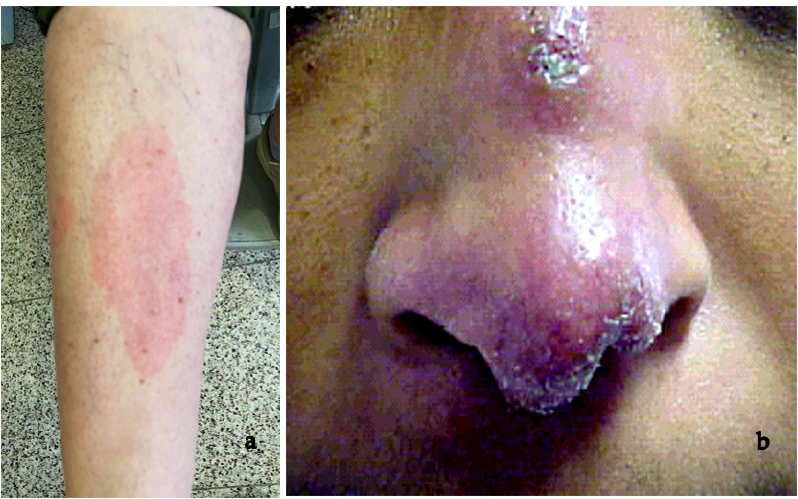
Figure 13. Skin sarcoid involvement. Erythema nodosum ( a ); lupus pernio ( b ).